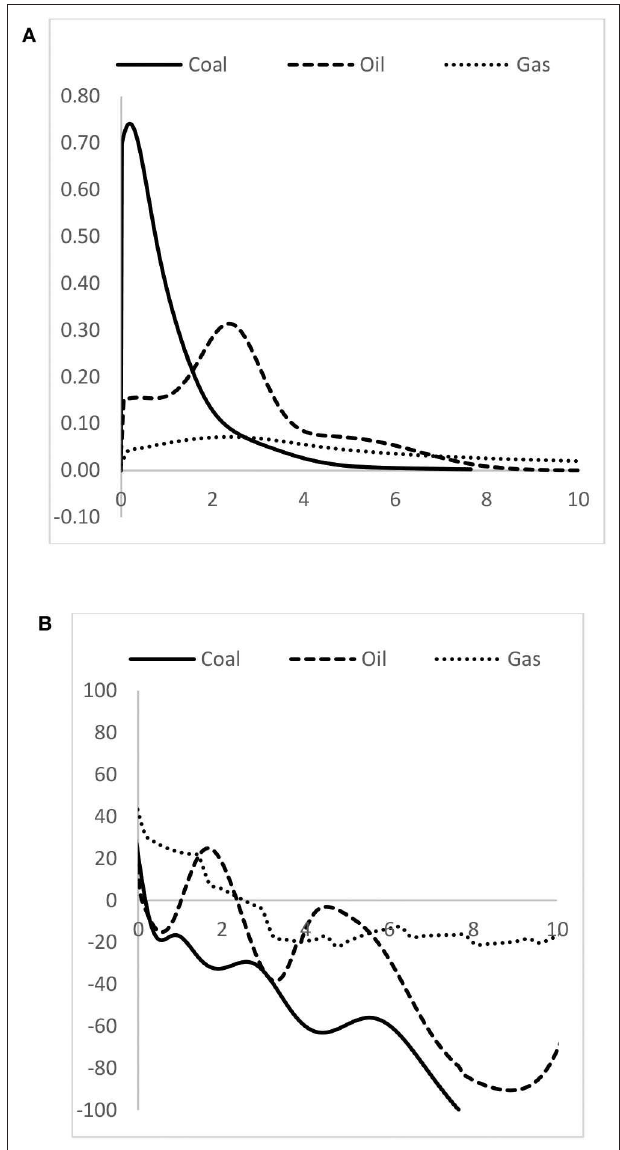
FIGURE 12 | Comparison of the ergodic distributions and MPPs of the coal, oil, and gas markets for the high-income countries. Note: For (A) , horizontal axis represents relative per capita consumption, vertical axis represents proportion. For (B) , horizontal axis represents relative per capita consumption, vertical axis represents MPP. Source: Authors’